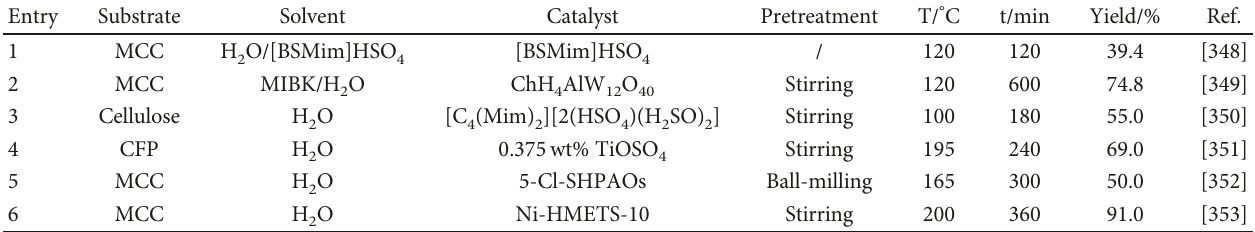
CFP: α cellulose from fi lter